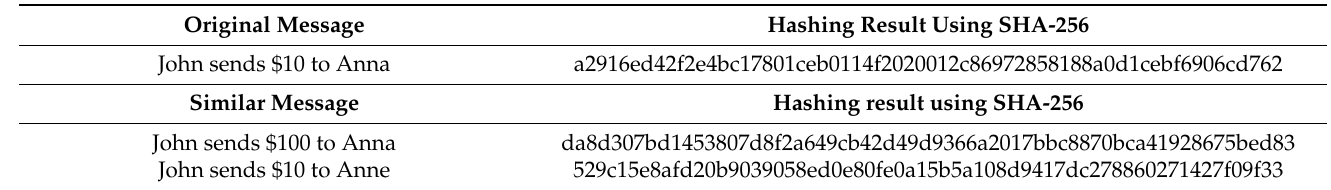
Figure 2. The miner puzzle-solving algorithm. Table 1. Sample of the similarity message produce the different hash output when using SHA-256. Table 1. SimBlock simulator parameter setting.